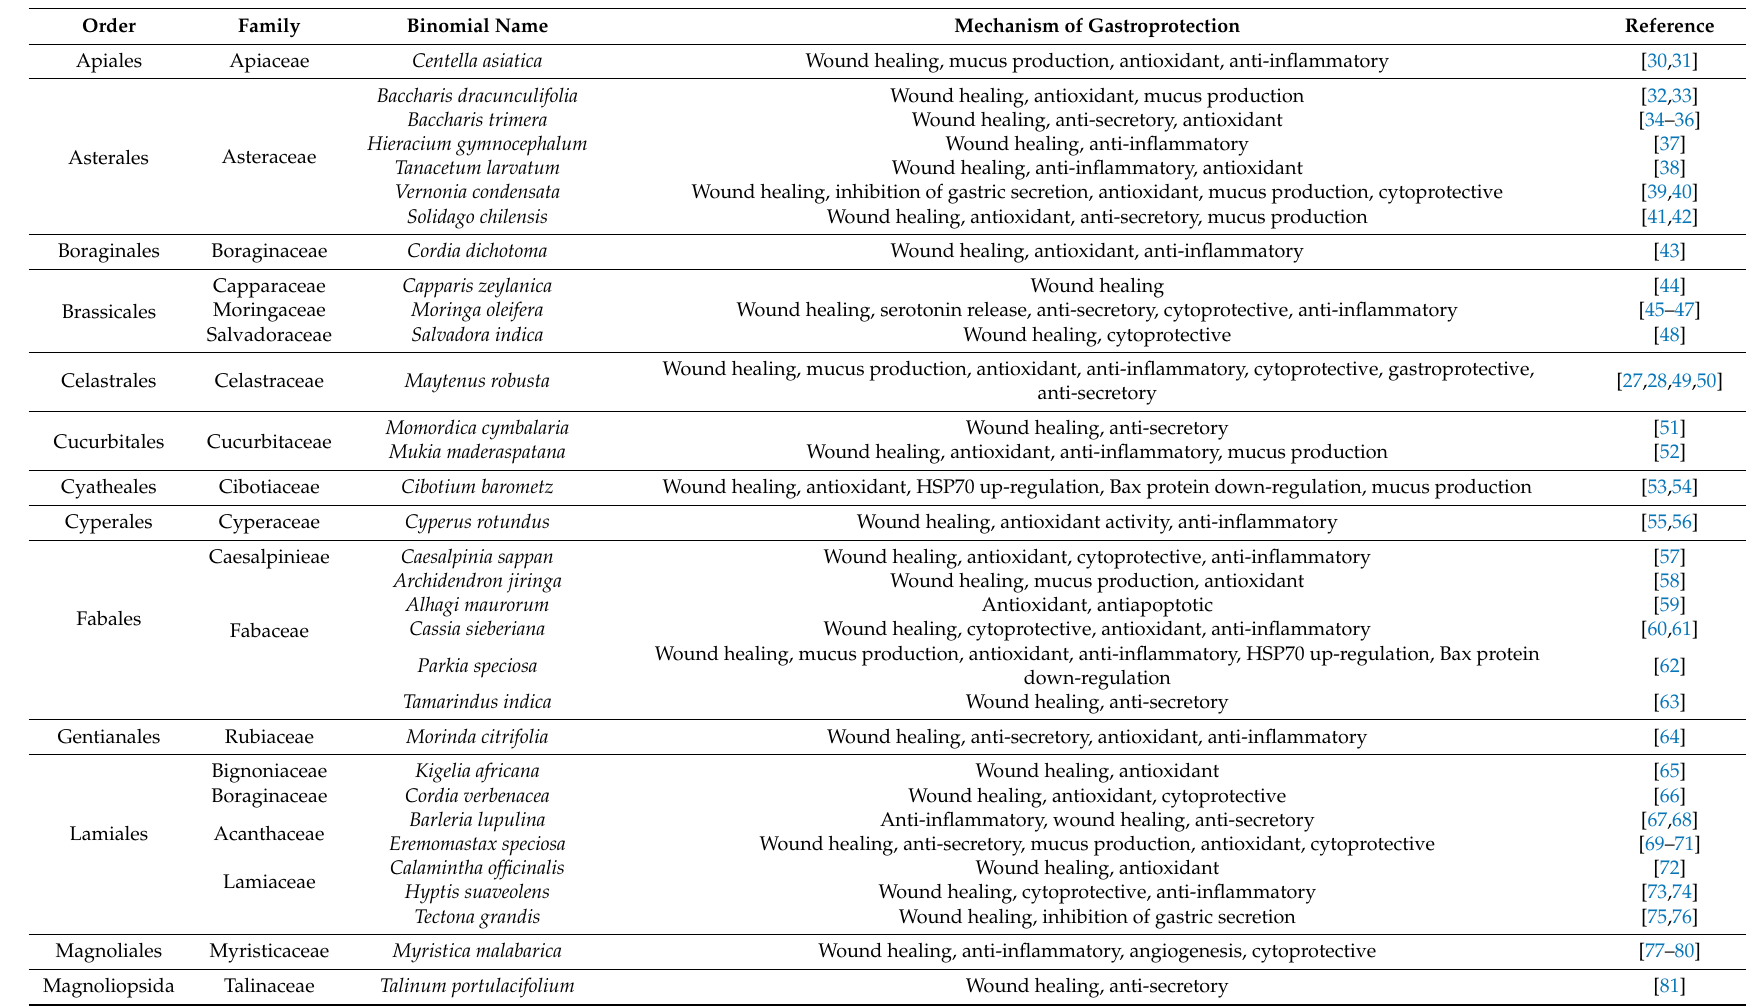
Table 2. Plant extracts with antiulcerogenic